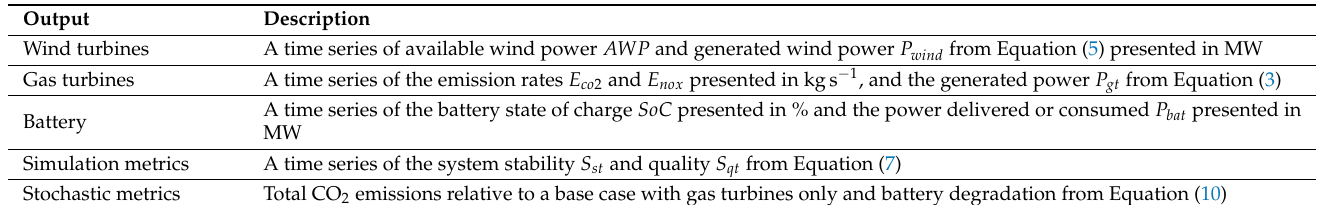
Table 3. Overview of the recorded simulation results.